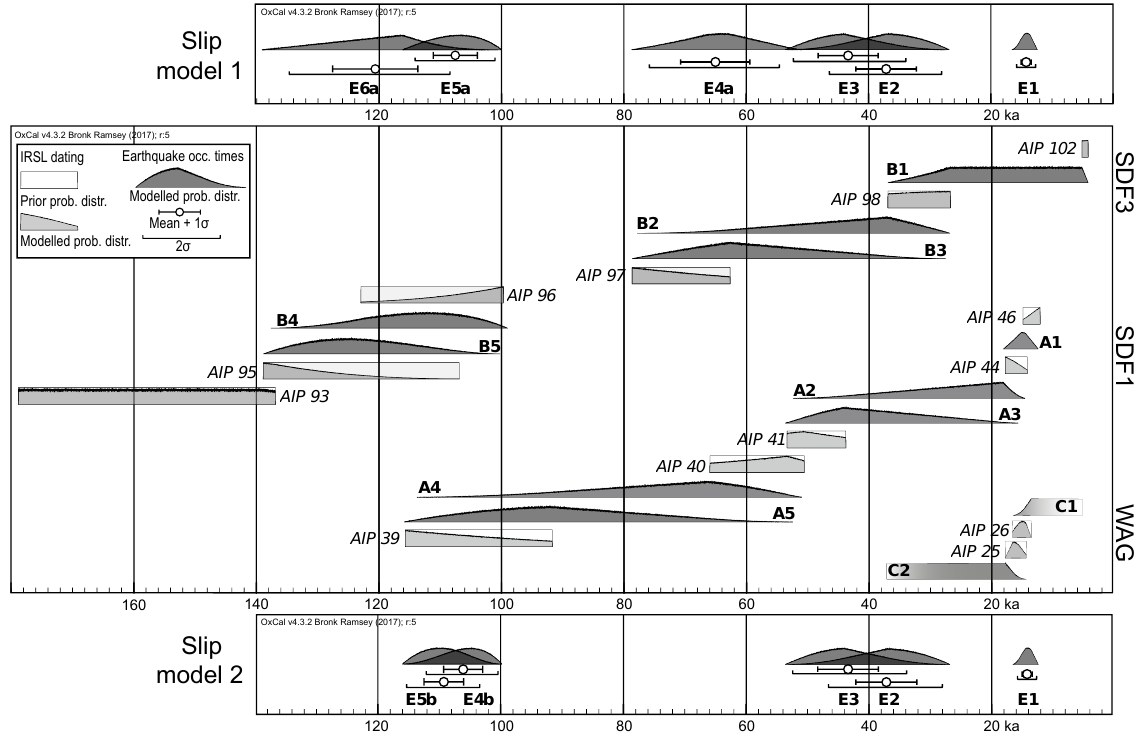
Figure 11. Comparison of age constraints from all trench sites (SDF1, SDF3, and WAG) and possible occurrence times of the observed earthquakes for the two possible slip models. The central panel shows the age constraints and earthquake occurrence times for each site separately. For the WAG site, only maximum constraint for C1 and minimum constraint for C2 are available. The upper and lower panels show the resultant earthquake occurrence times considering the combined chronostratigraphic constraints from all sites together for slip models 1 and 2, respectively. For details about correlation see Sect. 5. Calculations carried out using OxCal v4.3.2 (Bronk Ramsey, 1995,